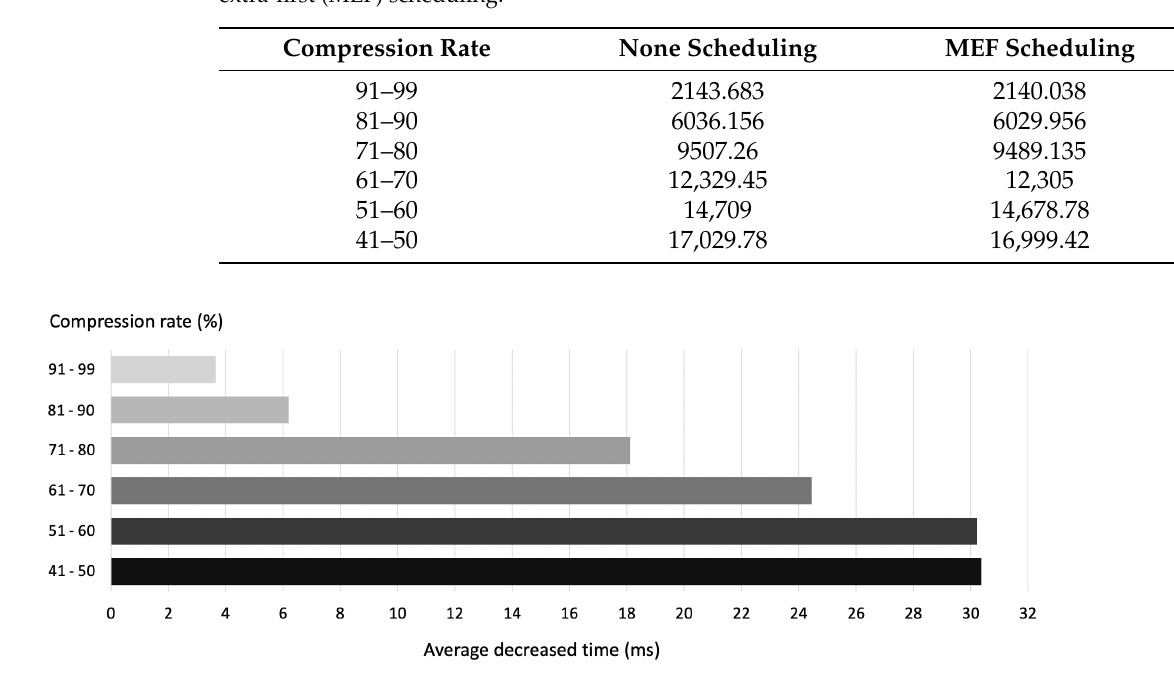
Figure 18. The average decreased transfer time using MEF scheduling according to compression